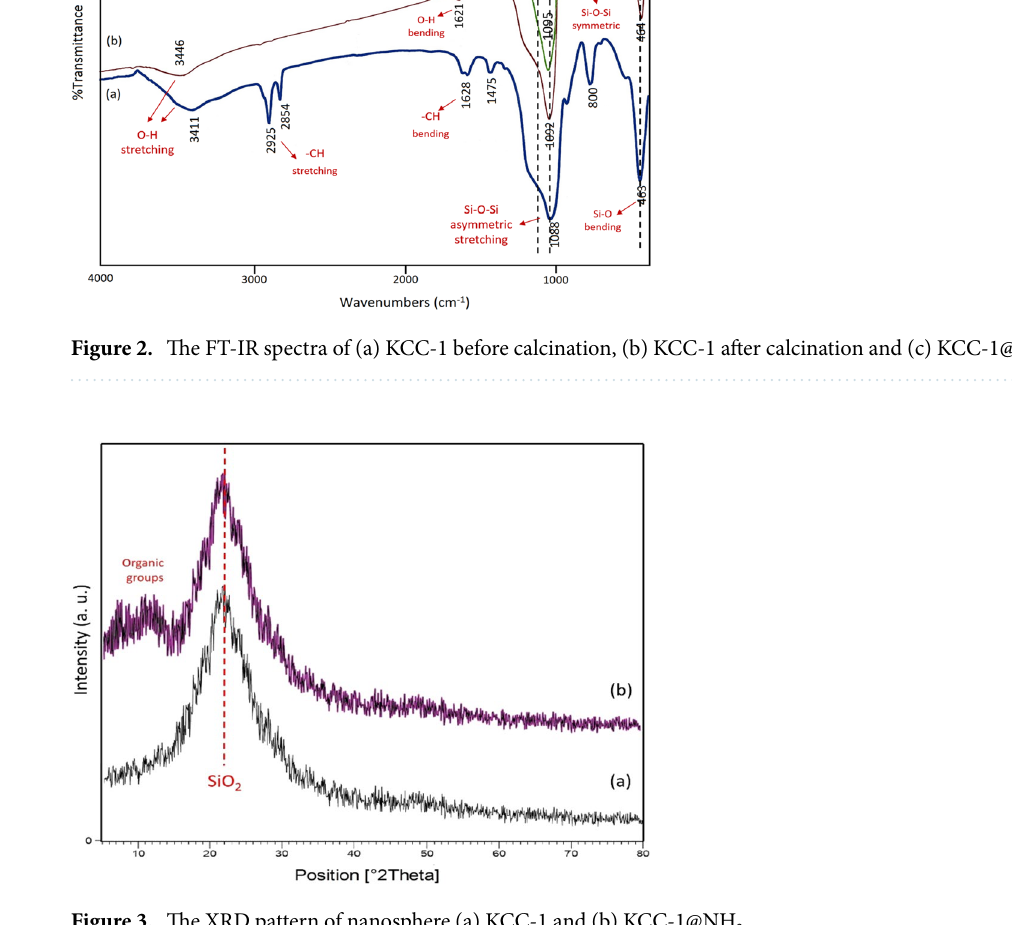
Figure 3. The XRD pattern of nanosphere (a) KCC-1 and (b) KCC-1@NH 2